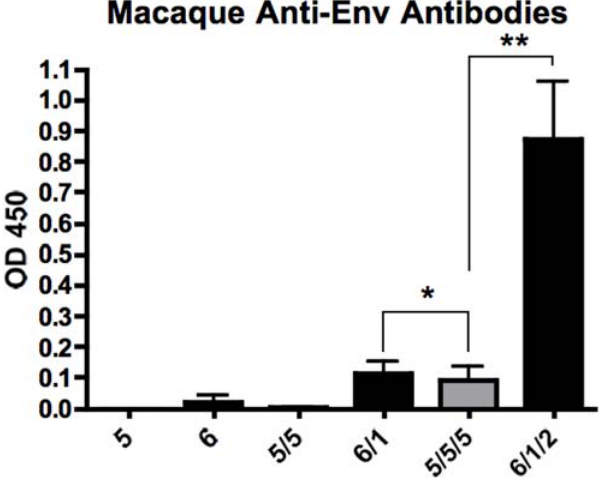
Figure 7. Evaluation of serotype switch in pre-immune macaques. Pre-immune macaques were immunized with 10 11 vp of homologous or heterologous HD-Ad expressing HIV-1 gp140 Env. The macaques were boosted with 10 11 vp of homologous or heterologous HD-Ad at days 24 and 67. Sera was collected on days 24, 67 and 100 and used to measure Anti-Env ELISA antibodies. Data is the mean of 4 macaques per group and error bars indicate standard error. Data was analyzed by one way ANOVA (*=p , 0.05 and **=p , 0.01).